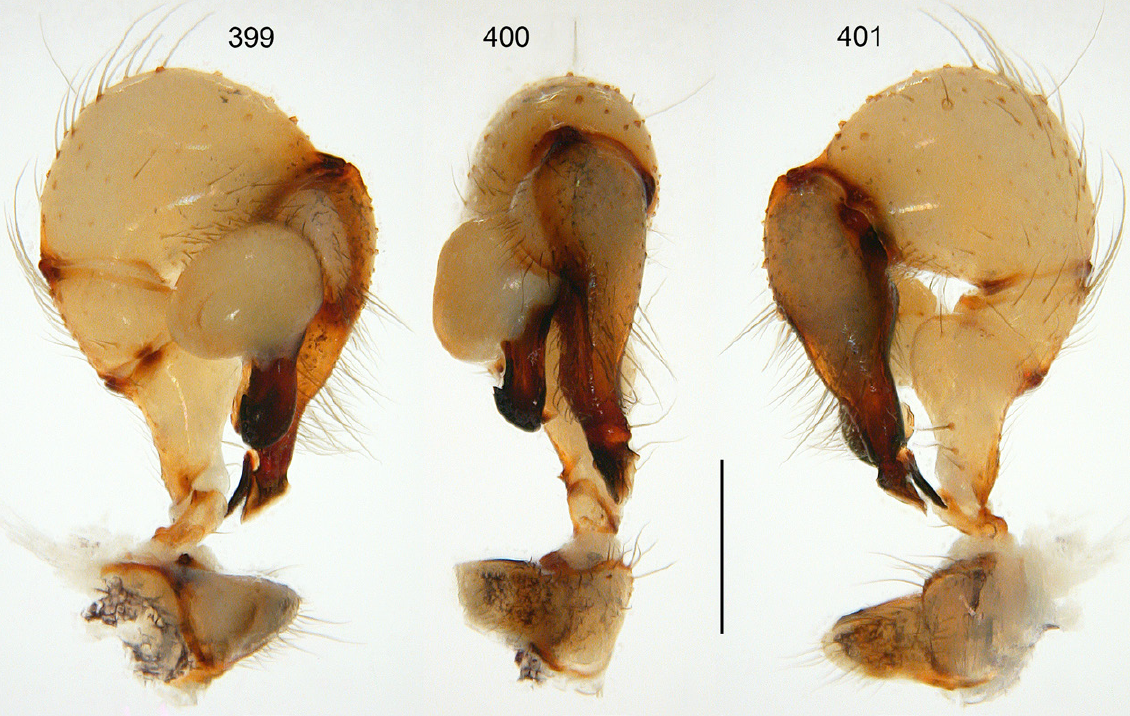
Figs 399–401. Crossopriza sahtan sp. nov.; male from Oman, above Wadi Sahtan (ZFMK Ar 22394); left palp, prolateral, dorsal, and retrolateral views. Scale bar = 0.5